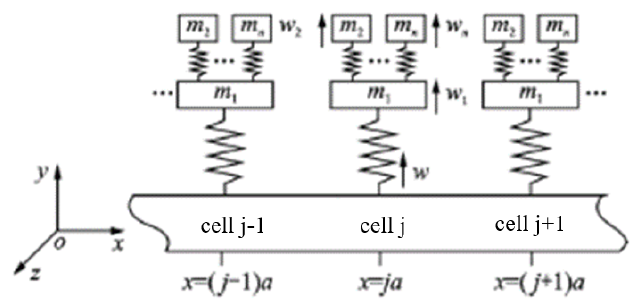
Figure 7. Schematic diagram of the suppressors periodically arranged on the base beam[37].